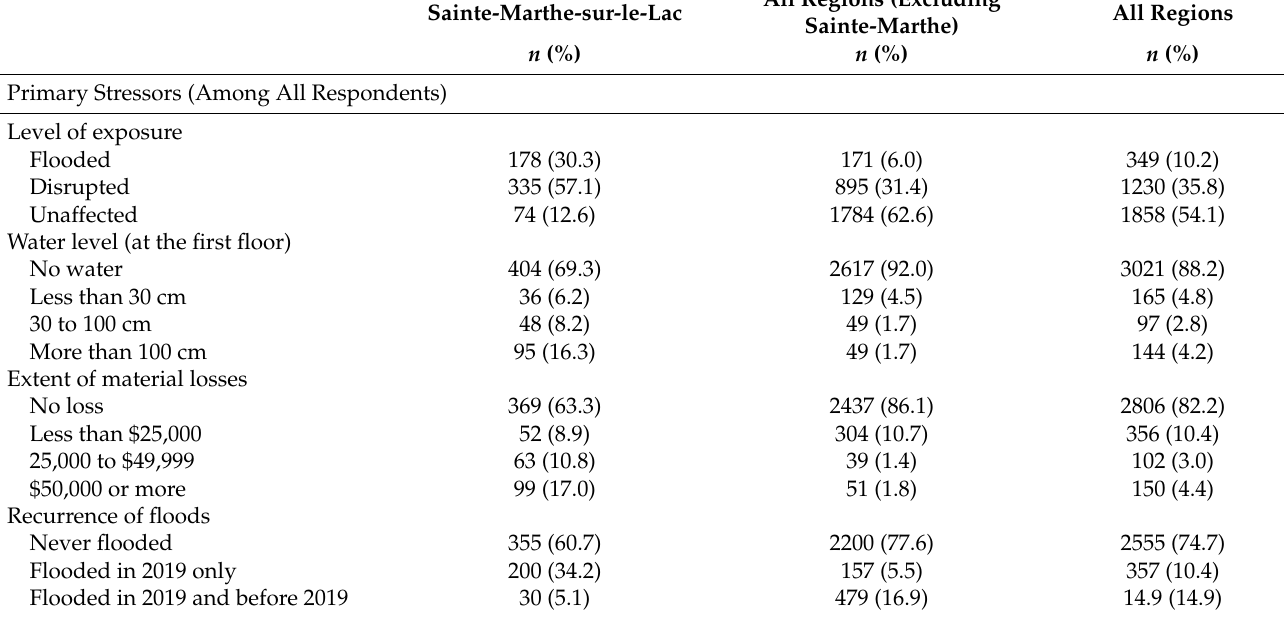
Table 2. Prevalence of primary and secondary stressors according to regions affected by